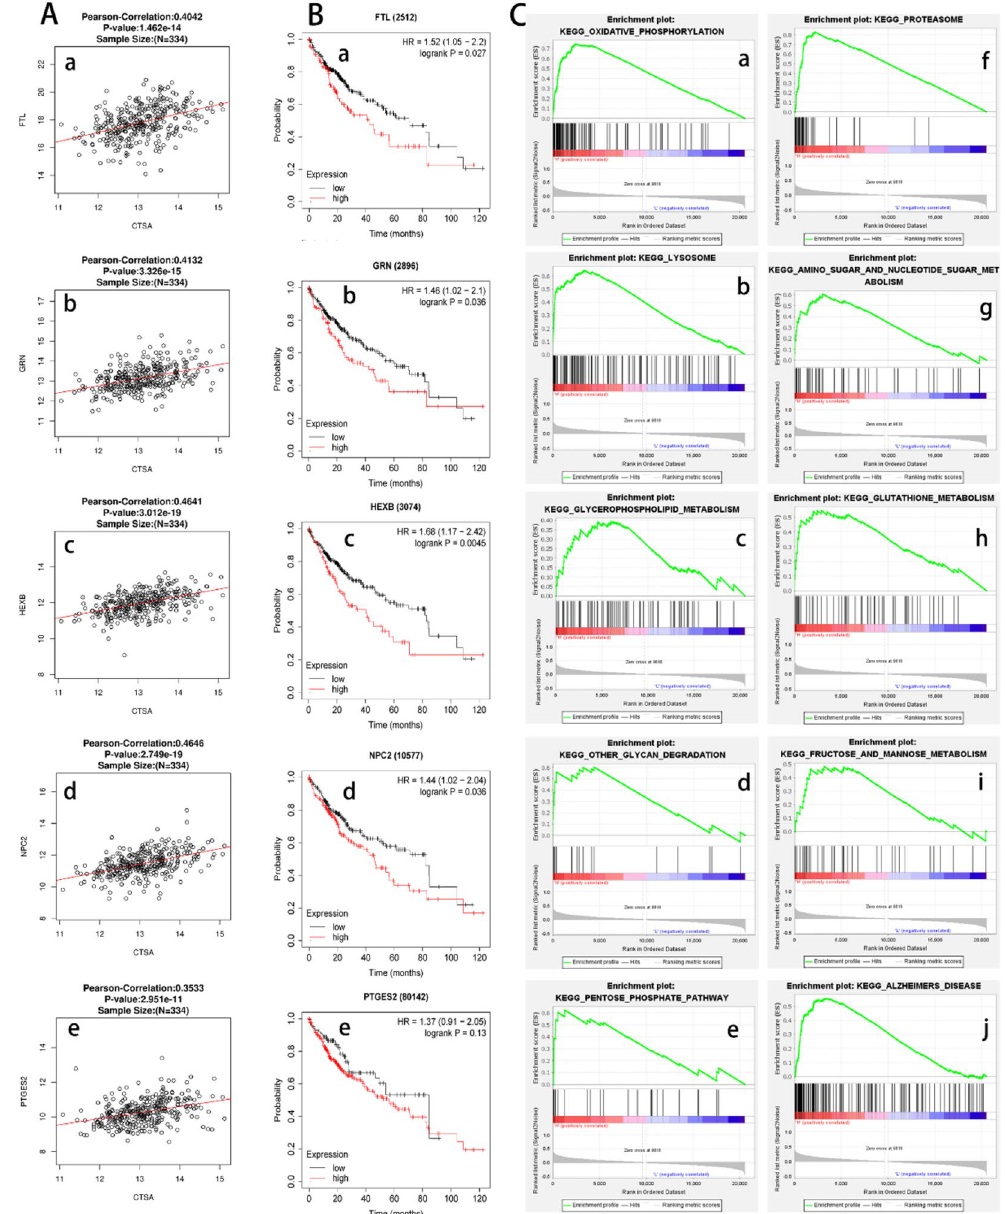
Figure 5. ( A ) Correlation between CTSA and FTL ( r = 0.4042), GRN ( r = 0.4132), HEXB (0.4641), NPC2, ( r = 0.4646), PTGES2 ( r = 0.3533), all P < 0.05. ( B ) The Kaplan–Meier curve showed that the mRNA expression of FTL, GRN, NPC2, and HEXB were significantly related to the OS in HCC patients (all P < 0.05). ( C ) The main enriched KEGG pathways of CTSA. OXIDATIVE PHOSPHORYLATION, LYSOSOME, OTHER GLYCAN DEGRADATION, PENTOSE PHOSPHATE PATHWAY, PROTEASOME, AMINO SUGAR AND NUCLEOTIDE SUGAR METABOLISM, GLUTATHIONE METABOLISM, FRUCTOSE AND MANNOSE METABOLISM, ALZHEIMERS DISEASE, GLYCEROPHOSPHOLIPID